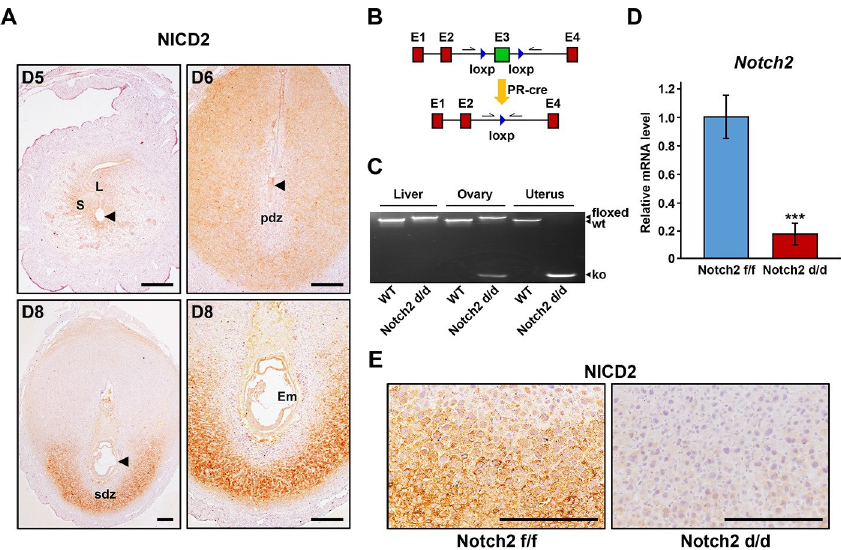
Fig 1. Notch2 was efficiently deleted in the uterus. (A) The spatiotemporal expression pattern of NICD2 in the uterus during early pregnancy was revealed by immunohistochemistry. Arrowheads indicate the developing embryo. L, luminal epithelium; S, stroma; pdz, primary decidual zone; sdz, secondary decidual zone; Em, embryo. Scale bar: 100 μ m. (B) The scheme shows the strategy of uterine-conditional Notch2 ablation. Arrows indicate primers used for the examination of knockout efficiency. (C) Genotyping analysis was carried out to validate knockout efficiency at DNA level in the liver, ovary and uterus. (D) Knockout efficiency at mRNA level in the uterus was further confirmed by QRT-PCR. Data are presented as mean ± SEM. (E) Immunohistochemistry staining of NICD2 revealed that Notch2 was efficiently ablated at protein level in the uterus. Scale bar: 100 μ m. ��� p <